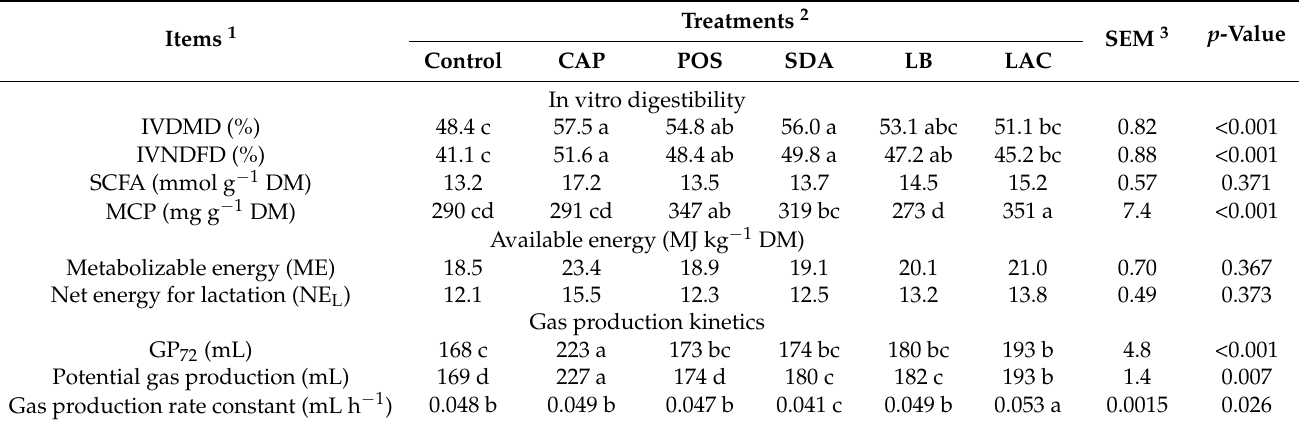
Table 6. In vitro gas production kinetics and digestibility, and available energy of total mixed ration silage after 95 days of